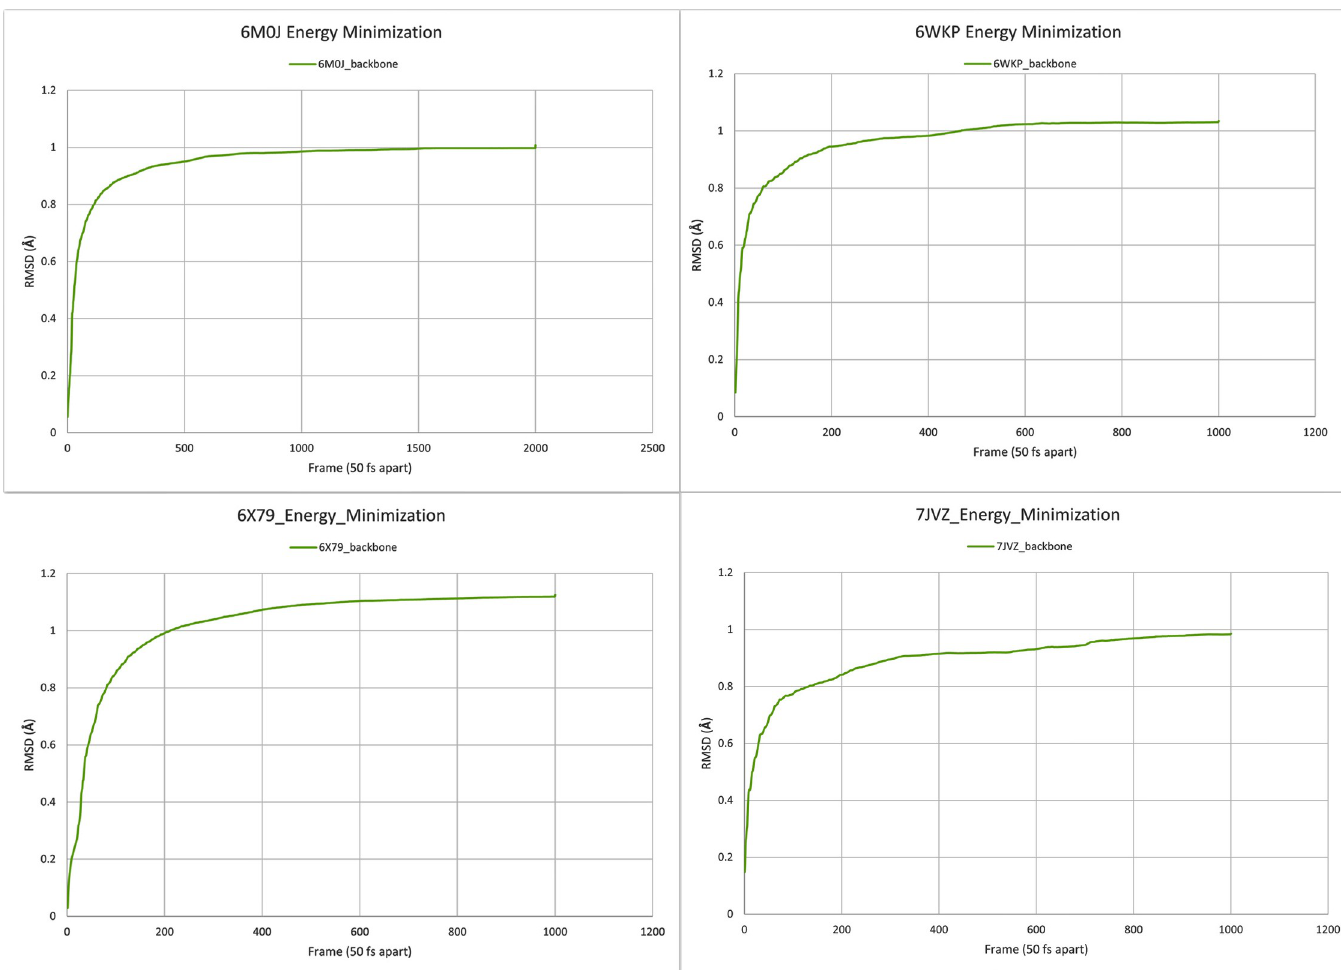
Fig 5. Analysis of minimization trajectory. 100.000 step steepest descent minimization for 6M0J and 50.000 step steepest descent minimization for 6WKP, 6X79, and 7JVZ. Backbone RMSD ( Å ) along the Y-axis and frames (50 fs distance between any 2 frames) along the X-axis.